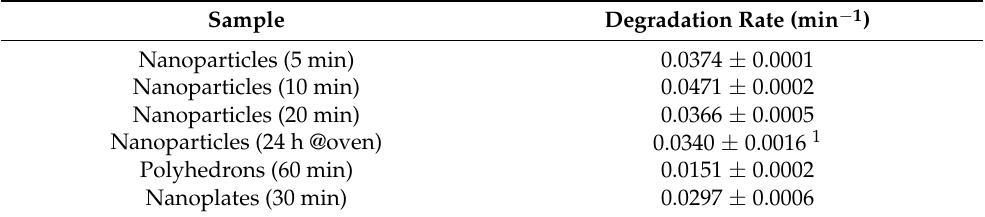
Table 3. Degradation rates of RhB in the presence of each ZTO nanostructures under UV light.